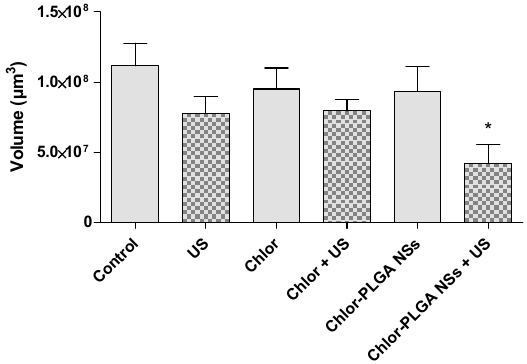
Figure 10. Effect of sonodynamic treatment on DU-145 spheroid volume. DU-145 spheroids were left untreated or treated with Chlor or Chlor-PLGA NSs (10 µM) for 24 h and then, where required, exposed to US (1.5 MHz for 5 min at 1.5 W/cm 2 ). Data are expressed as spheroid volume (µm 3 ). Statistically significant vs. control: * p < 0.05.